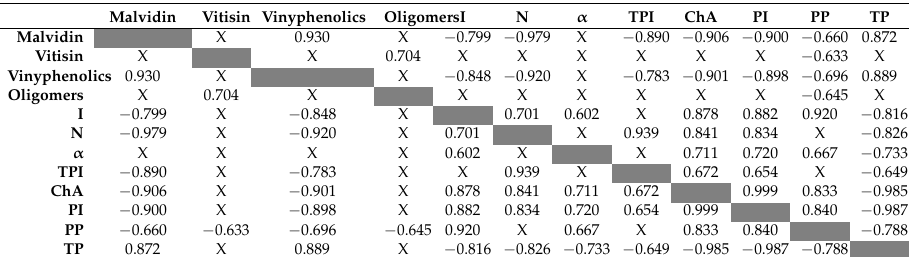
Table 6. Pearson correlation plot for pigments and colour indexes. X indicates values not significant at 5%. P -values below 0.05 indicate statistically significant non-zero correlations. R values = +0.7 or higher indicate very strong positive relationship while, R values = − 0.7 or higher indicate very strong negative